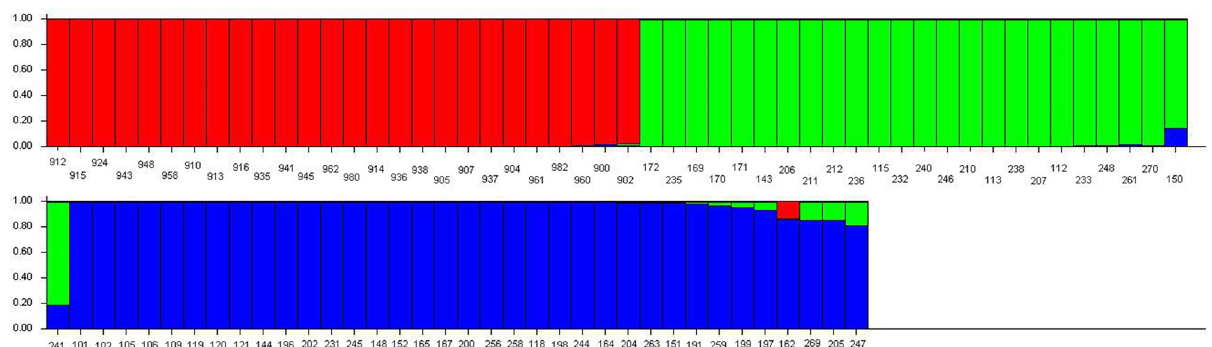
Fig 2. Q value distribution of P . armeniaca var. ansu K = 3. The 86 accessions were divided into subpopulations S1 to S3, comprised of 26 (red), 25 (green), and 35 (blue) accessions.